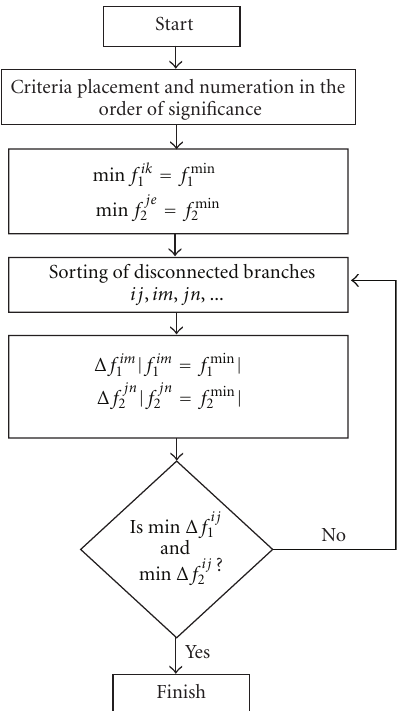
Start Criteria placement and numeration in the order of significance